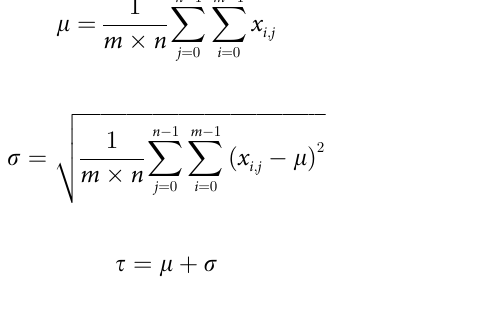
Where is the value of a grayscale image pixel point; i is the row index; x i , j